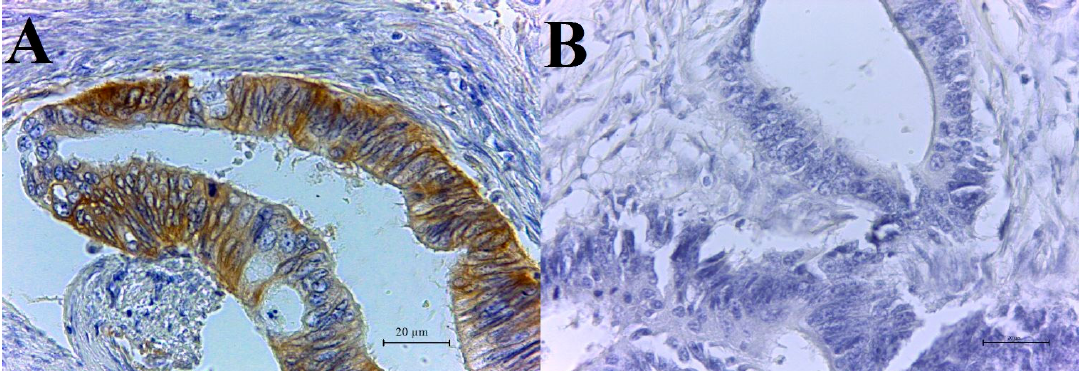
Figure 1. Immunohistochemical detection of CAIX with DAB staining: (A) CAIX-positive colorectal adenocarcinoma (high magnification), (B) CAIX-negative colorectal adenocarcinoma (high magnification).